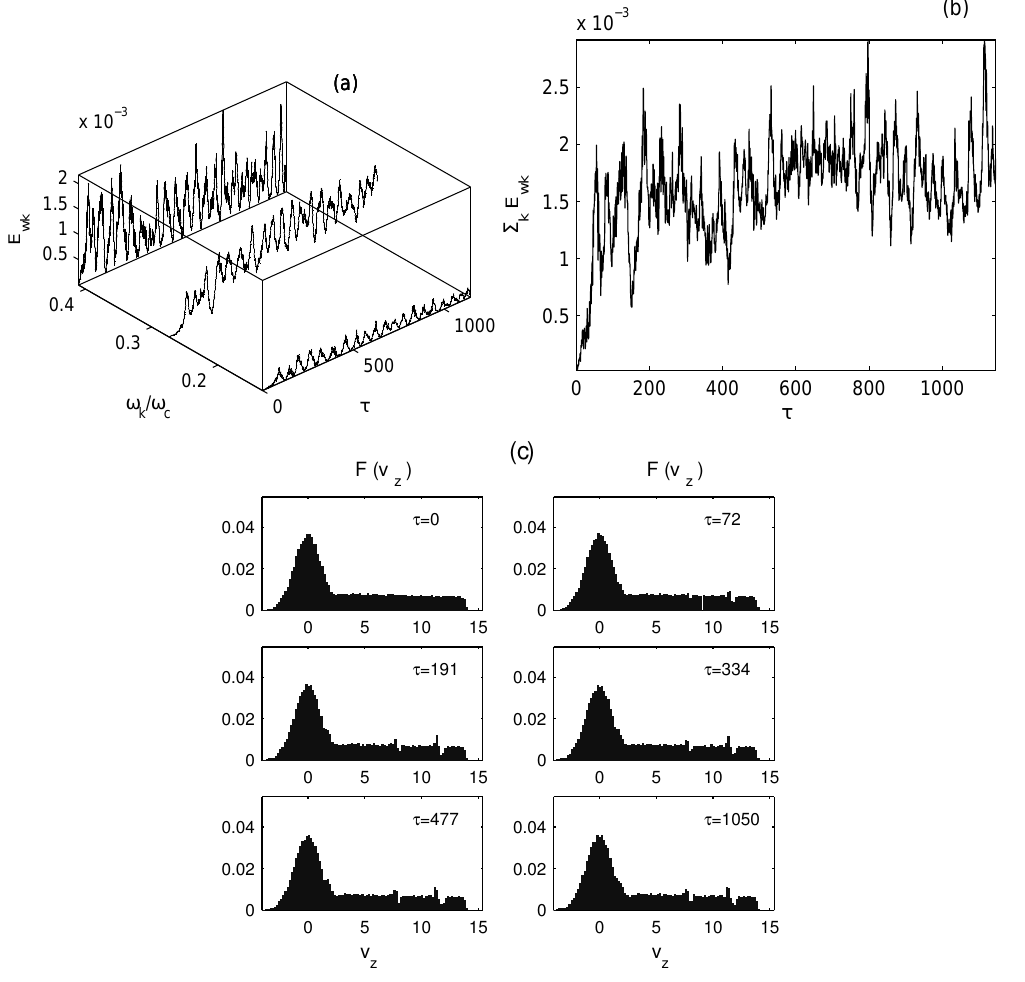
+ ω Fig. 2. Resonant three-waves decay ( k = k 1 + k 2 and ω k = ω k k 2 ) in the presence of a suprathermal tail of electrons extending in the 1 parallel direction v z > 0 (wave-wave interaction terms are not neglected). Variation as a function of the normalized time τ (a) of the normalized wave energy density E wk of each of the three waves (each wave is indicated by its normalized frequency ω k /ω c ) and (b) of the total normalized wave energy density P k E wk ; (c) Parallel velocity distribution function F(v z ) at different times: τ = 0 , 72 , 191 , 334 , 477 , 1050 . The main normalized parameters and the initial particle distribution functions are the same as in the Fig.